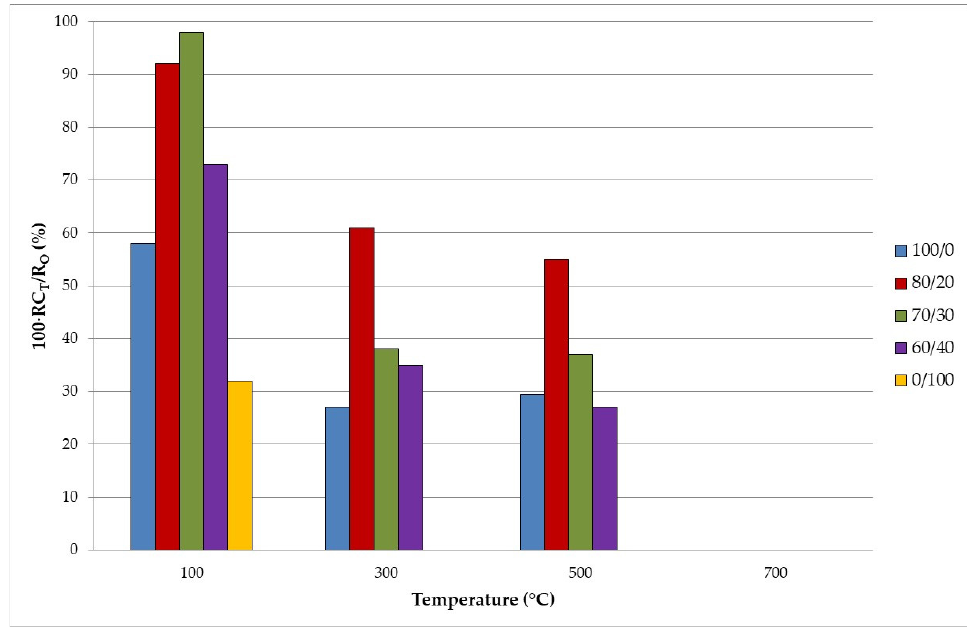
Figure 7. Evolution of compressive strength with temperature.